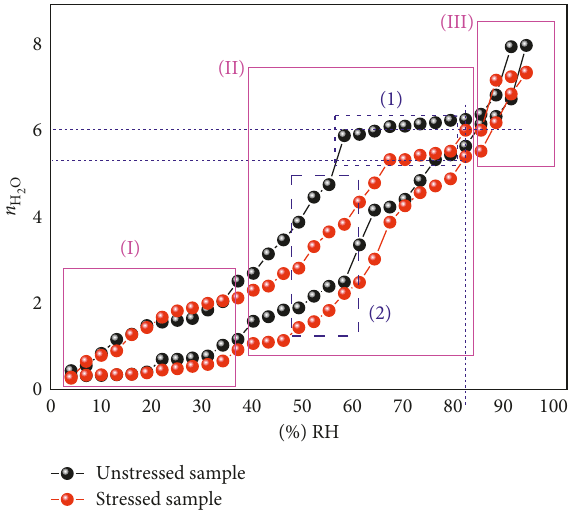
Figure 8: Evolution of the water molecule amounts ( n %RH. The bottom black curve represents the sorption process of the unstressed sample. The red curve at the bottom represents the sorption process of the stressed sample. For (1) and (2) in blue, see